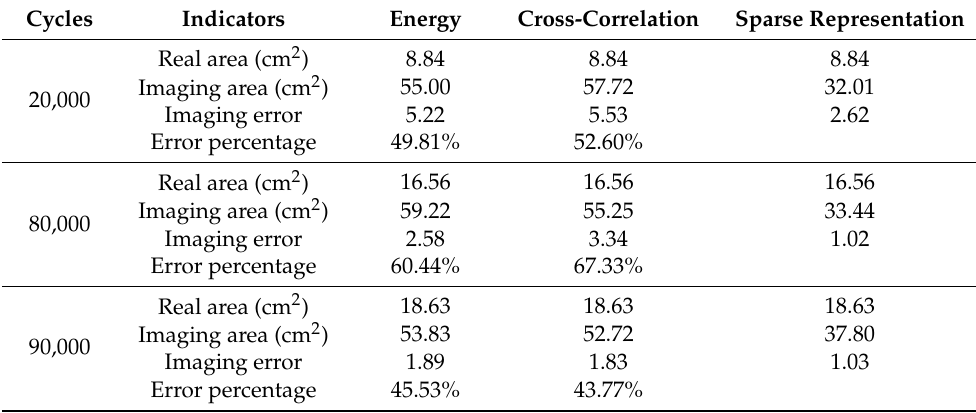
Table 1. Imaging error and error percentage for different damage factors.